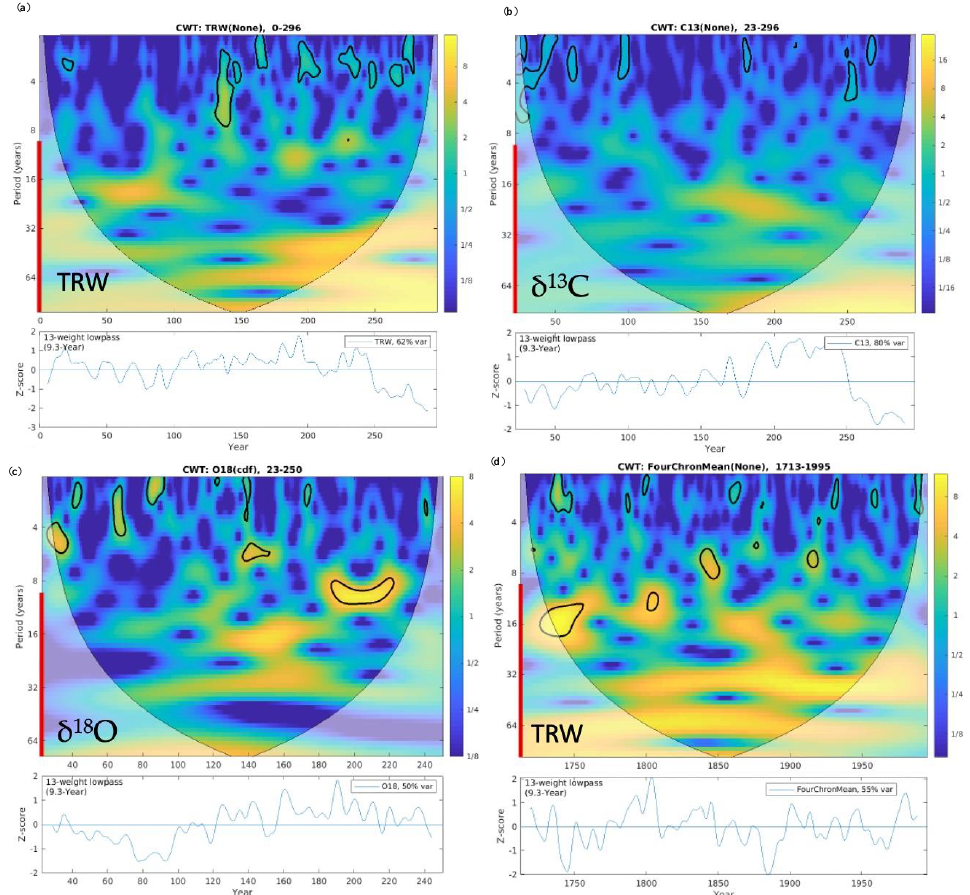
Figure 4. Continuous wavelet transforms (CWT) and smoothed plots of tree-ring time series. ( a ) Ring-width index chronology, floating, 297 years, for Douglas fir from an ancient landslide in Oregon Coastal Range, ca. 62,000 years ago. ( b ) δ 13 C from a 228-year sequence of rings from the same wood samples. ( c ) δ 18 O from the same rings as δ 13 C. ( d ) Ring-width index of the average of four modern Douglas fir chronologies from central Oregon (see Supplementary Materials Table S4 for site details). CWT describes variance as a function of time and frequency, with areas significant (95%) relative to red noise enclosed by solid black line. Color mapping, with the key at right, is spectral power (high variance yellow, low variance blue). The title at top gives the name of the series, whether it was transformed (none were), and the year sequences (relative for floating, absolute for modern). Series smoothed by a low-pass Hamming filter (number of weights and 50% response wavelength annotated) are plotted below CWT. Red vertical bar to the left of CWT marks the approximate range of wavelengths passed by the filter; the percentage of the original variance retained in the smoothed series is annotated in the box in the upper right of the time plot.